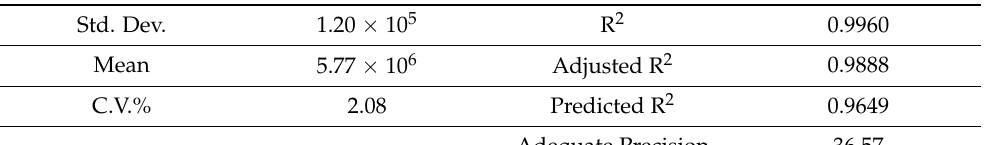
Table 3. Results of the analysis of the suitability of the experimental model (CV: coefficient of variation).